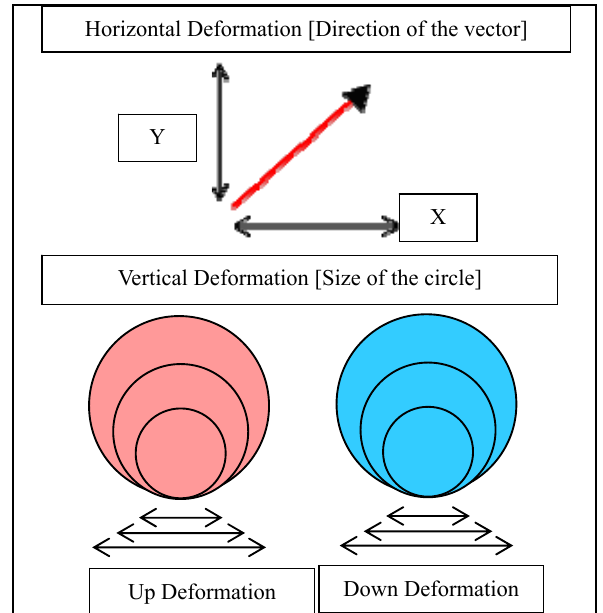
Figure 4. Coordinate Transform blocks Horizontal Deformation [Direction of the vector]